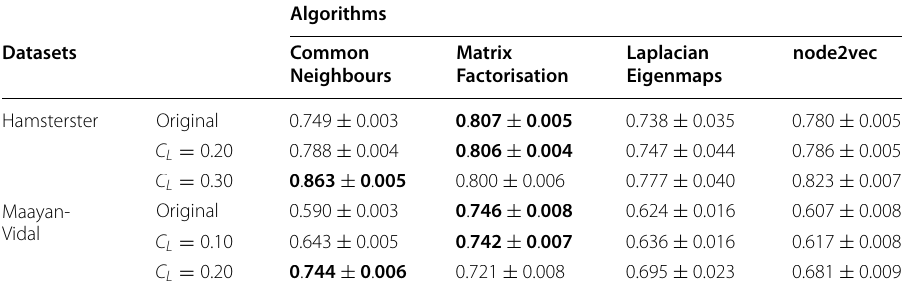
Table 4 AUC for all the algorithms applied to real networks Hamsterster and Maayan‑Vidal and their rewired